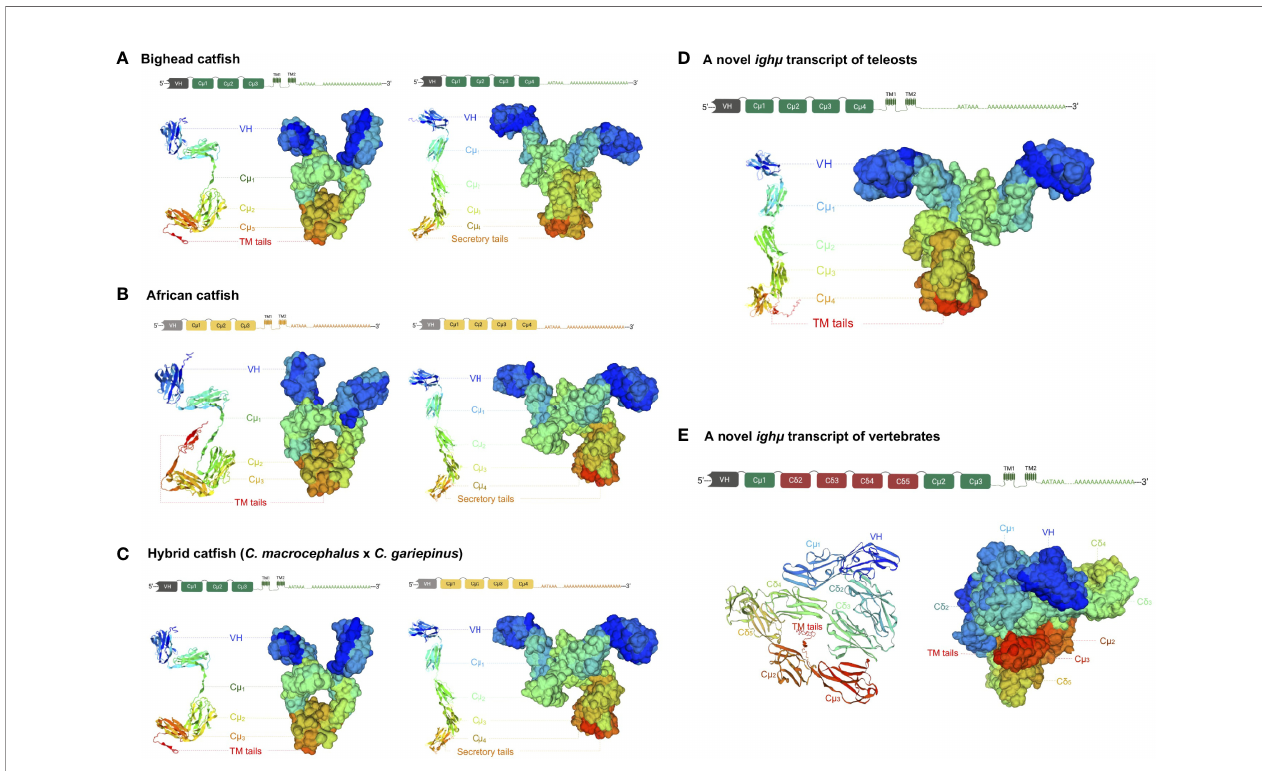
FIGURE 3 | The predicted crystal protein structures of Igh m transcripts expressed in the membrane and secreted forms in different cat fi sh: bighead cat fi sh (A) , North African cat fi sh (B) , and their hybrid cat fi sh (C) . The more complex molecules of two novel Igh m transcripts found in bighead cat fi sh are illustrated in (D, E)